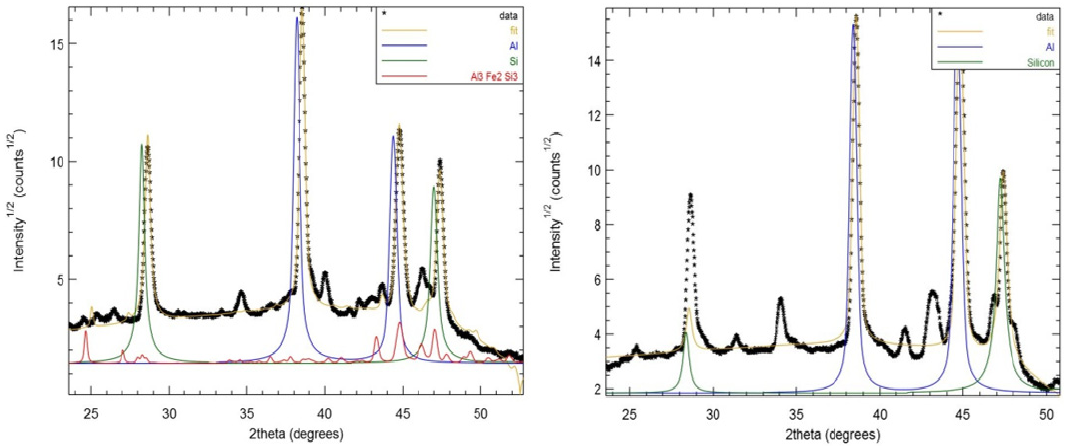
Figure 13. Left : XRD pattern of S263 as-delivered state; Right : As welded at 1 m/min.